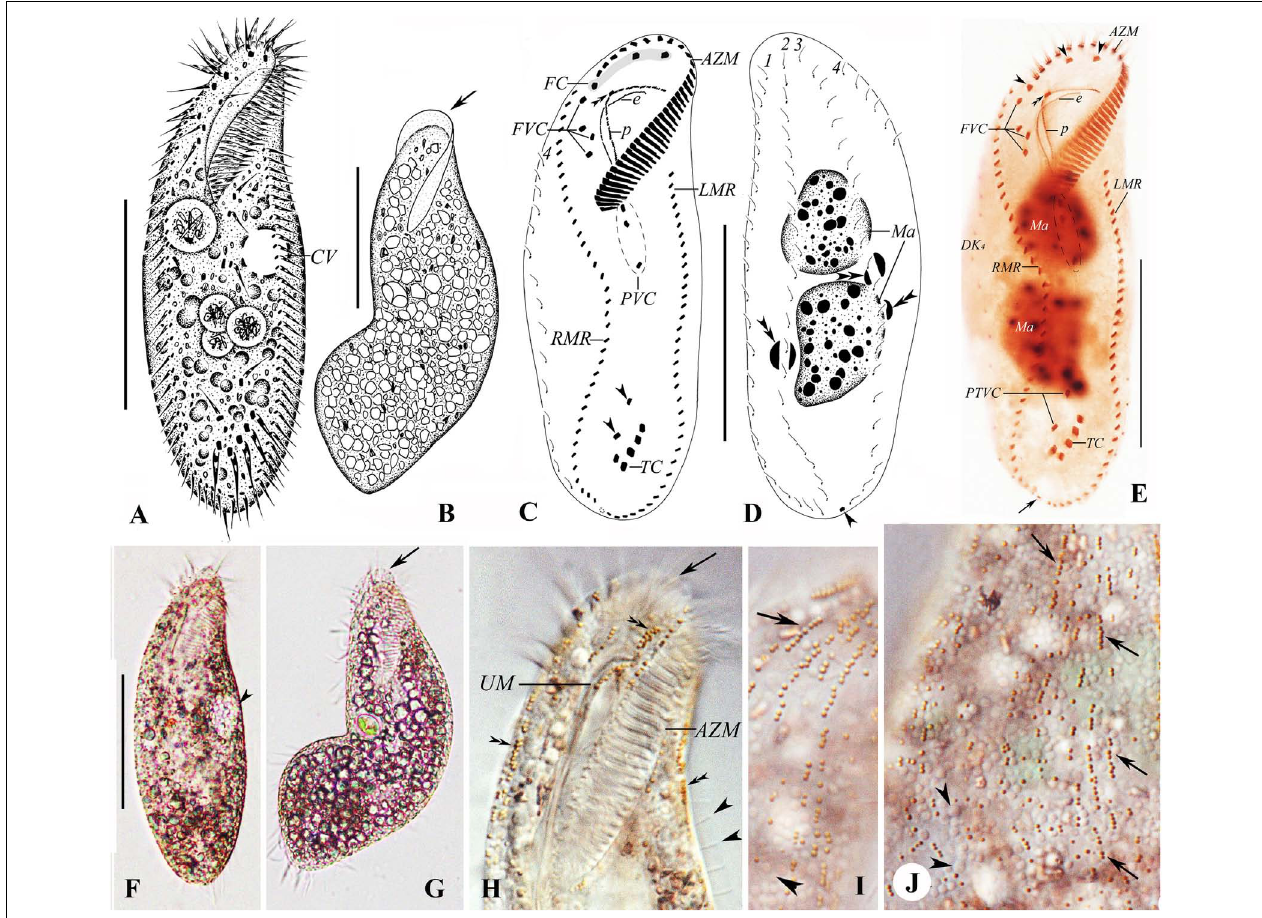
FIGURE 7 | (A–J) Morphology and ciliature of Rubrioxytricha guangzhouensis spec. nov. from life ( A,B,F,G , bright field; H–J , differential interference contrast) and after protargol impregnation (C–E) . (A–J) From Chen et al. (2015). (A) Ventral view of a representative individual. (B) Ventral view of a bending cell to show the flexibility of the body; arrow marks the frontal scutum. (C–E) Ventral (C,E) and dorsal (D) views of the holotype specimen, showing ciliature and nuclear apparatus; arrowheads in (C) mark pretransverse ventral cirri; double arrowheads in (C,E) mark buccal cirrus; double arrowheads in (D) show micronuclei; arrow in (D,E) indicates the single caudal cirrus; arrows in (E) show frontal cirri. (F) Ventral view of the typical individual; arrowhead marks the contractile vacuole. (G) Ventral view of bending cell to show the flexibility of the body; arrow marks the transparent membrane-like structure at the anterior part of the adoral zone. (H) Ventral view of anterior cell part; arrow marks the transparent membrane-like structure at the anterior part of the adoral zone; double arrowheads indicate the reddish-brown, spherical, type-I cortical granules; arrowheads indicate the dorsal bristles. (I,J) Dorsal views of the anterior (I) and middle (J) cell parts; arrows indicate the reddish-brown, spherical, type-I cortical granules arranged in lines; arrowheads mark the colorless, densely distributed, mitochondria-like granules. AZM, adoral zone of membranelles; CV, contractile vacuole; e, endoral membrane; FC, frontal cirri; FVC, frontoventral cirri; LMR, left marginal row; Ma, macronuclear nodules; p, paroral membrane; PVC, postoral ventral cirri; RMR, right marginal row; TC, transverse cirri; UM, undulating membranes; 1–4, dorsal kineties. Scale bars = 60 µ